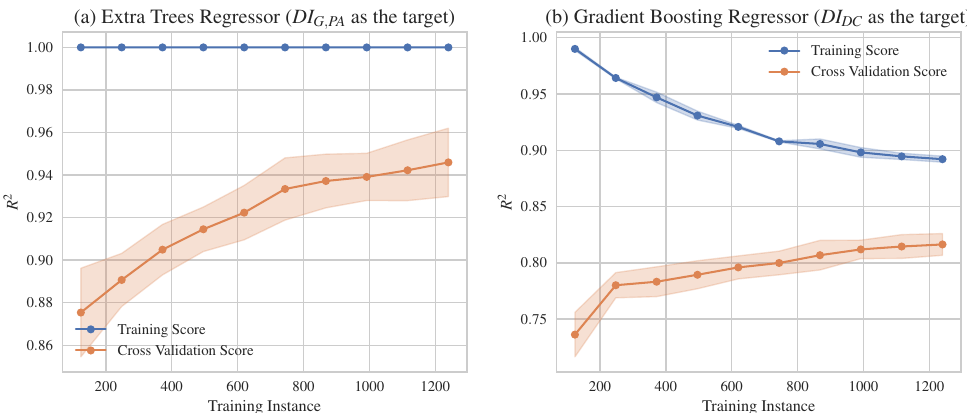
Figure 10. Learning curves of the MLAs with the best predictive capacity for ( a ) the prediction of DI G,PA and ( b ) the prediction of DI DC